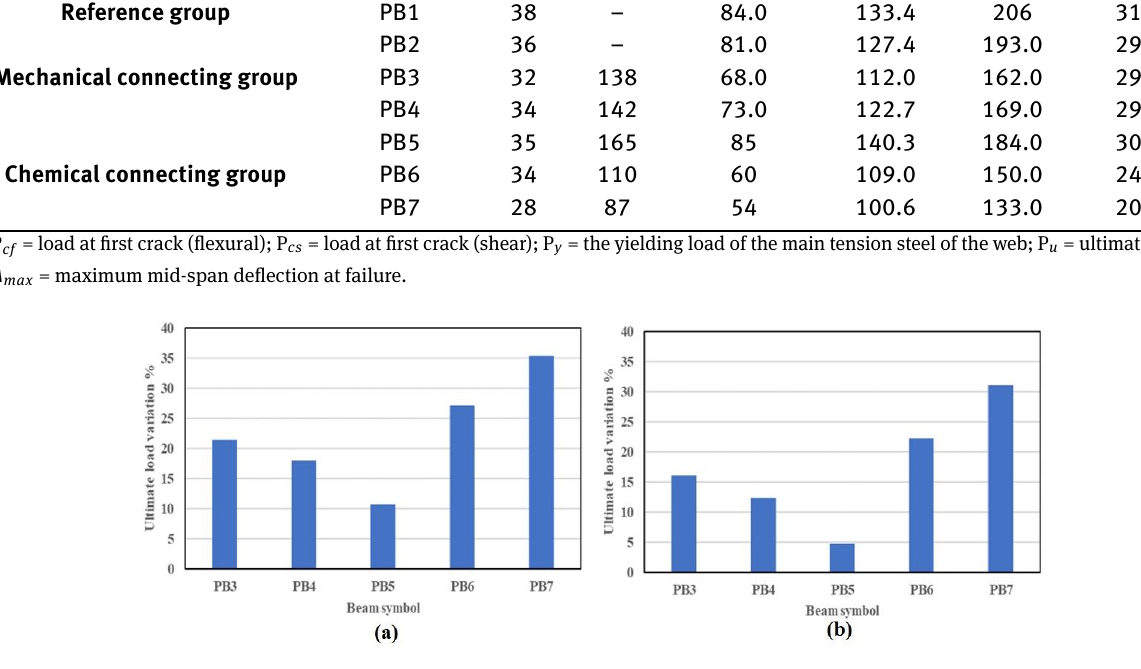
Figure 6: Ultimate load carrying capacity variation (%) of the composite beams to the reference specimens (a) PB1; (b)